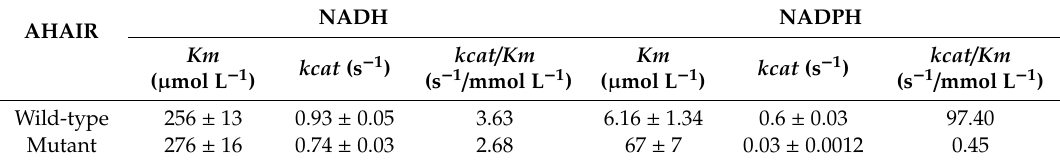
Table 2. Kinetic parameters of the wild-type and mutant AHAIRs for NADH or NADPH a . NADH NADPH AHAIR